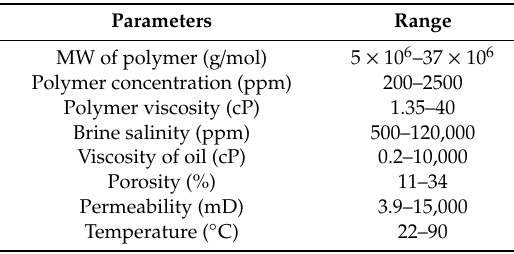
Table 4. Summarized range of conditions for pilot-scale polymer application.